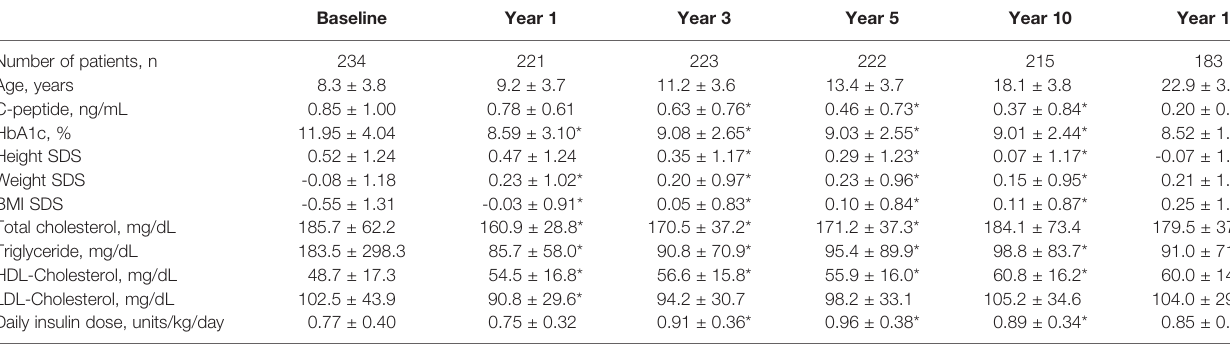
TABLE 1 | Clinical and biochemical characteristics of type 1 diabetes mellitus patients over 15